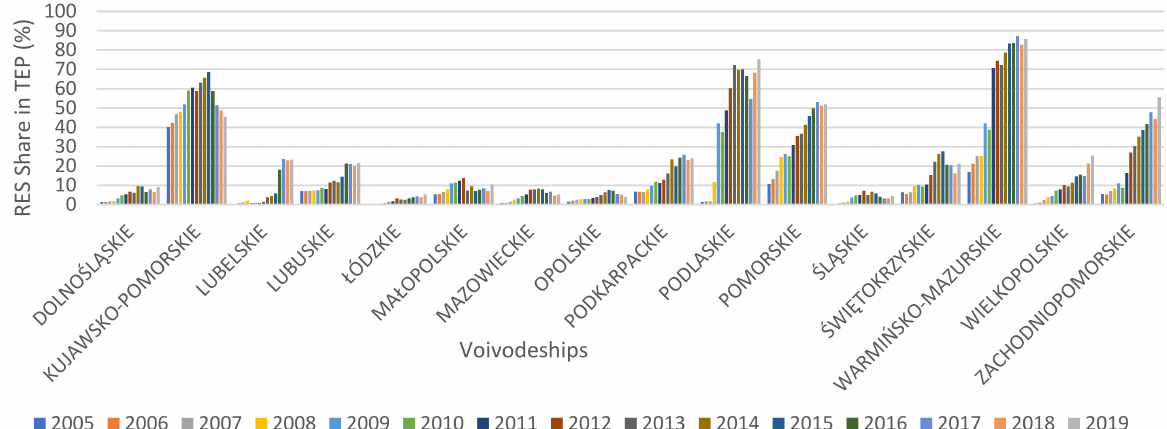
Figure A6. RES production share in individual voivodeships in the total electricity production (TEP) in Poland in 2005–2019 (%). Source: Own calculations based on the